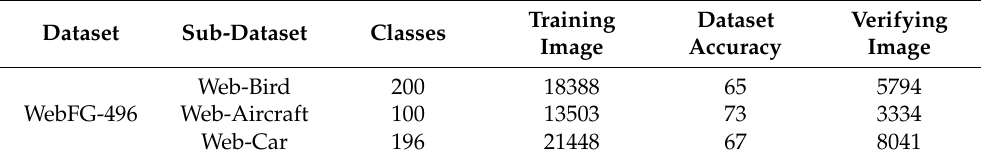
Table 1. This is the number of categories, the number of images and the estimation accuracy(%) of training images for each subdataset, where the estimation accuracy is estimated using a subset of random